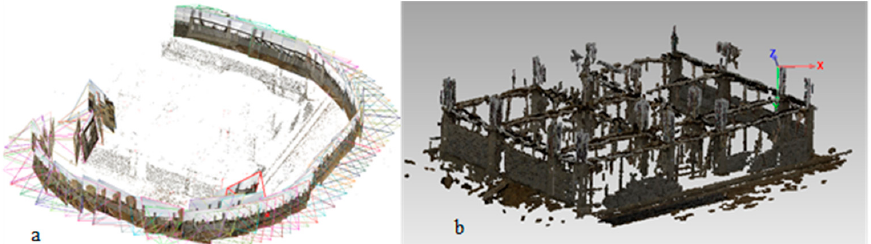
Figure 7. Generated point could for the second case study: ( a ) The sparse point cloud, ( b ) the dense point cloud.